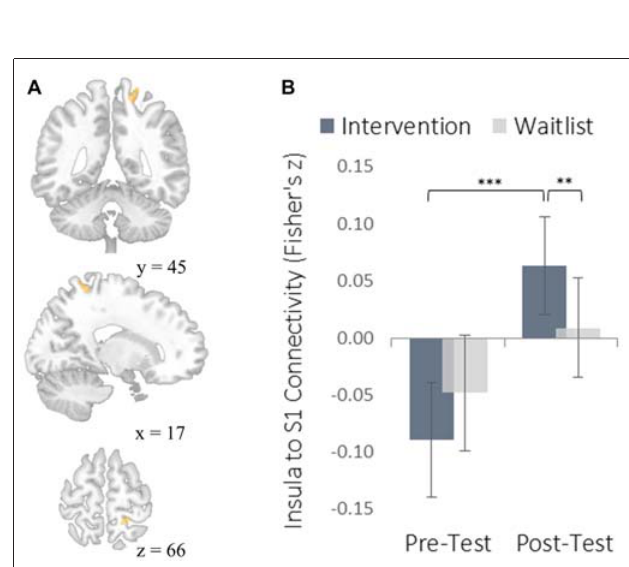
FIGURE 5 | Functional connectivity results using the degree-centrality-based insula seed region. (A) The location of a significant cluster in the right somatosensory cortex demonstrating increased functional connectivity with the insula seed; MNI peak-coordinate: (46, − 20, 20). Cluster forming threshold set at p < 0.001 and cluster size threshold set at p < 0.05 (FDR corrected). (B) Mean Fisher r- to- z transformed functional connectivity values for the intervention and waitlist groups at pre-testing and post-testing. ∗∗ p < 0.01, ∗∗∗ p < 0.001. Error bars represent 95% confidence